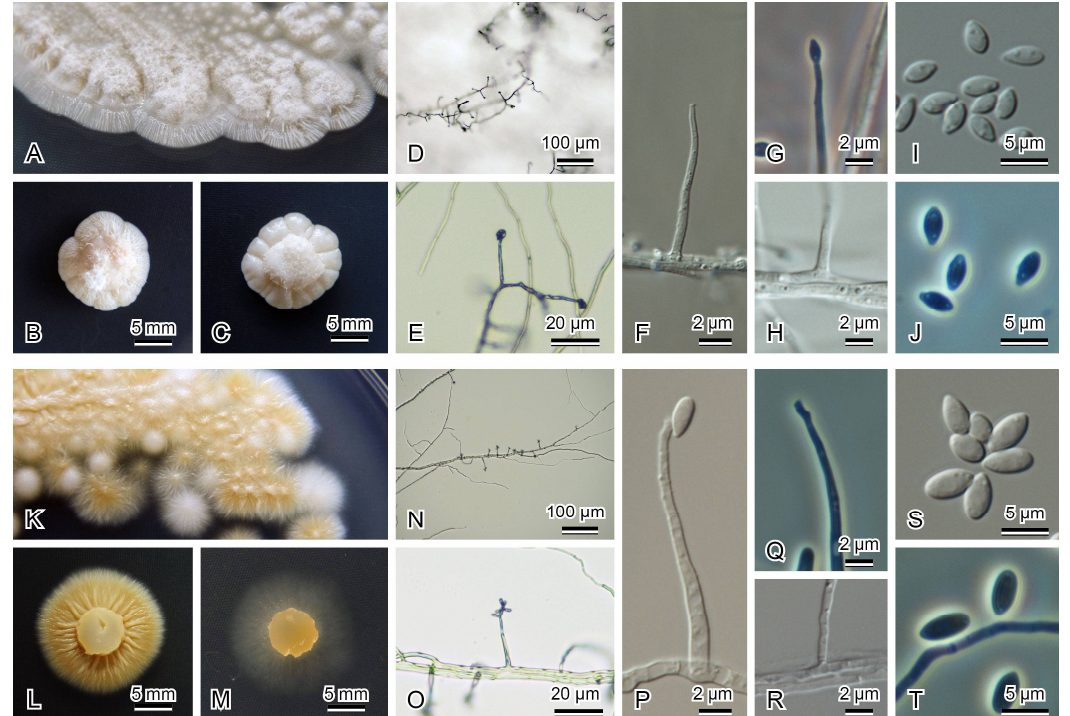
Figure 3. Acremoniunm sp. and “ Acrodontium ” cf. salmoneum . ( A–J ) Acremonium sp. ( A , B from JCM 39226, C from JCM 39227, D – J from JCM 39225). ( A – C ) Colonies on PDA after 10 days at 28 ◦ C. ( D , E ) Conidiogenous cells on hyphae. ( F – H ) Conidiogenous cells. ( I , J ) Conidia. ( K – T ) “ Acrodontium ” cf. salmoneum (JCM 39229). ( K , L ) Colonies on PDA after 8 days at 20 ◦ C. ( M ) Colonies on MEA after 8 days at 20 ◦ C. ( N , O ) Conidiogenous cells on hyphae. ( P – R ) Conidiogenous cells. ( S , T ) Conidia.